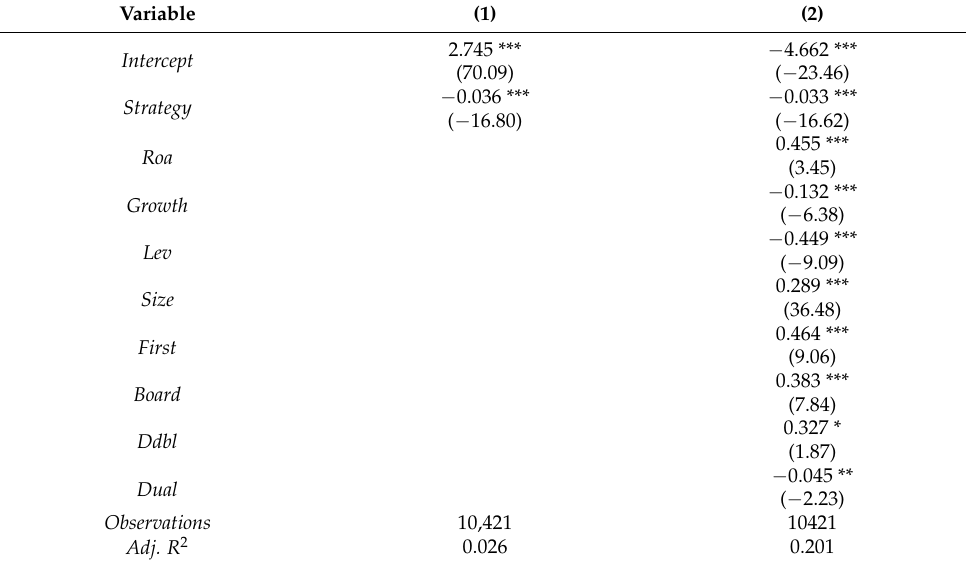
Table 6. Business strategy and environmental information disclosure